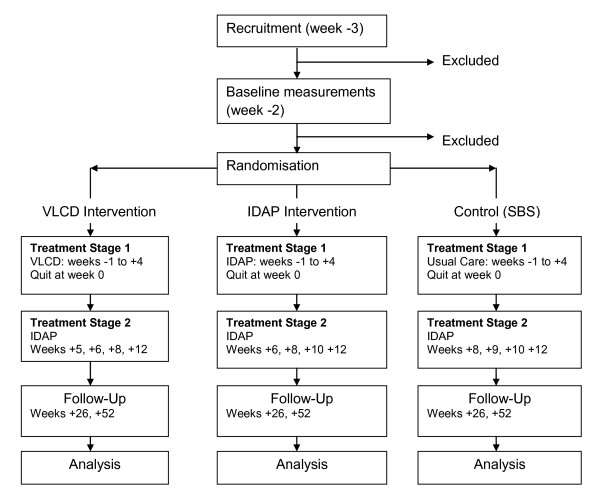
Phases in DeMiST.